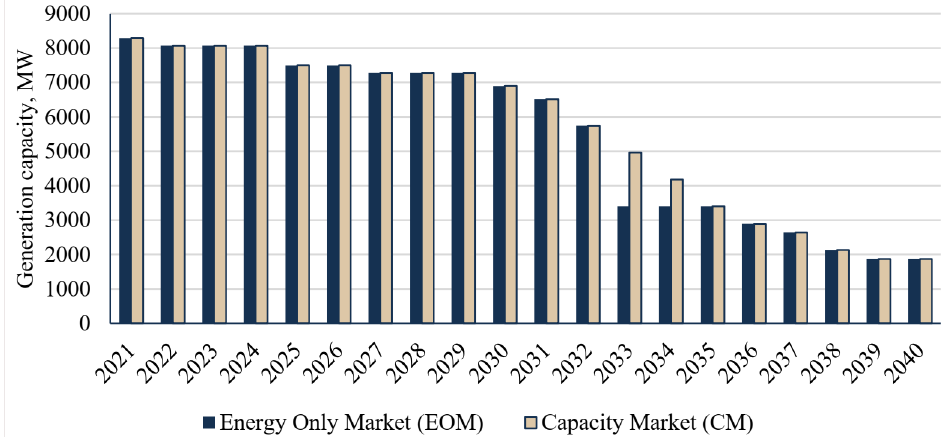
Figure 12. Lignite-fired generation capacity under the EOM and CM scenarios in